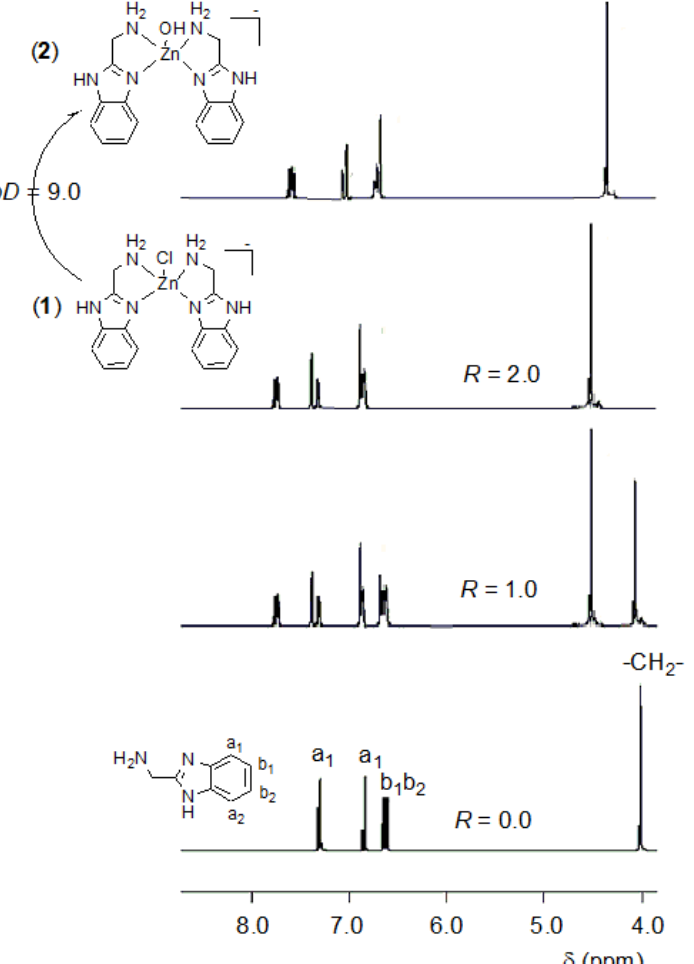
Figure 4. 1 H NMR titration of zinc(II) complex 1 (2.0 × 10 − 3 M) as a function of pD in CD 3 OD:D 2 O (3:1, I = 0.1 M NaNO 3 , 25 ± 0.1 °C).